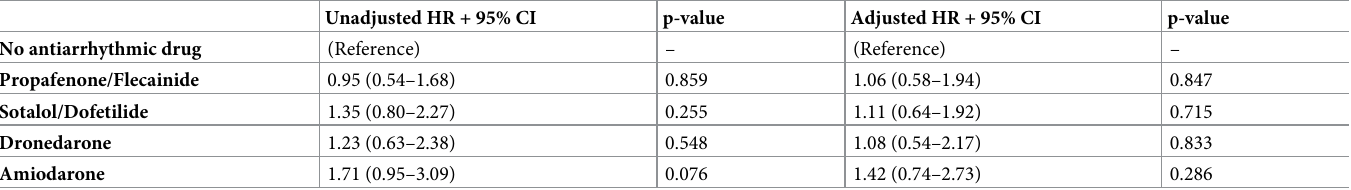
Table 2. Unadjusted and adjusted Cox proportional hazard ratios for early recurrence: AF/AFL/AT recurrence within three-month blanking period (No AAD is ref- erence group). Unadjusted HR + 95% CI p-value Adjusted HR + 95%